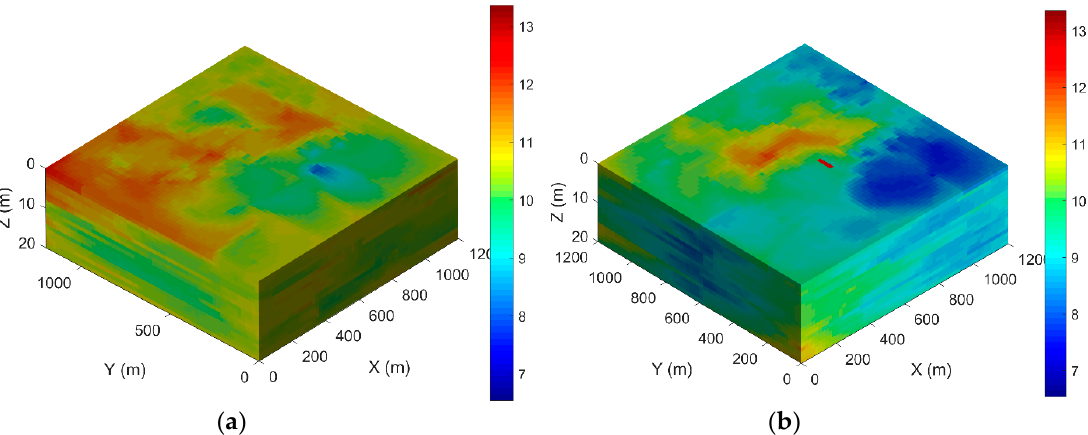
Figure 13. Simulated distributions of the residence time, in Log 10 scale, for the ( a ) initial and ( b ) optimal well designs in the three-dimensional heterogeneous aquifer.